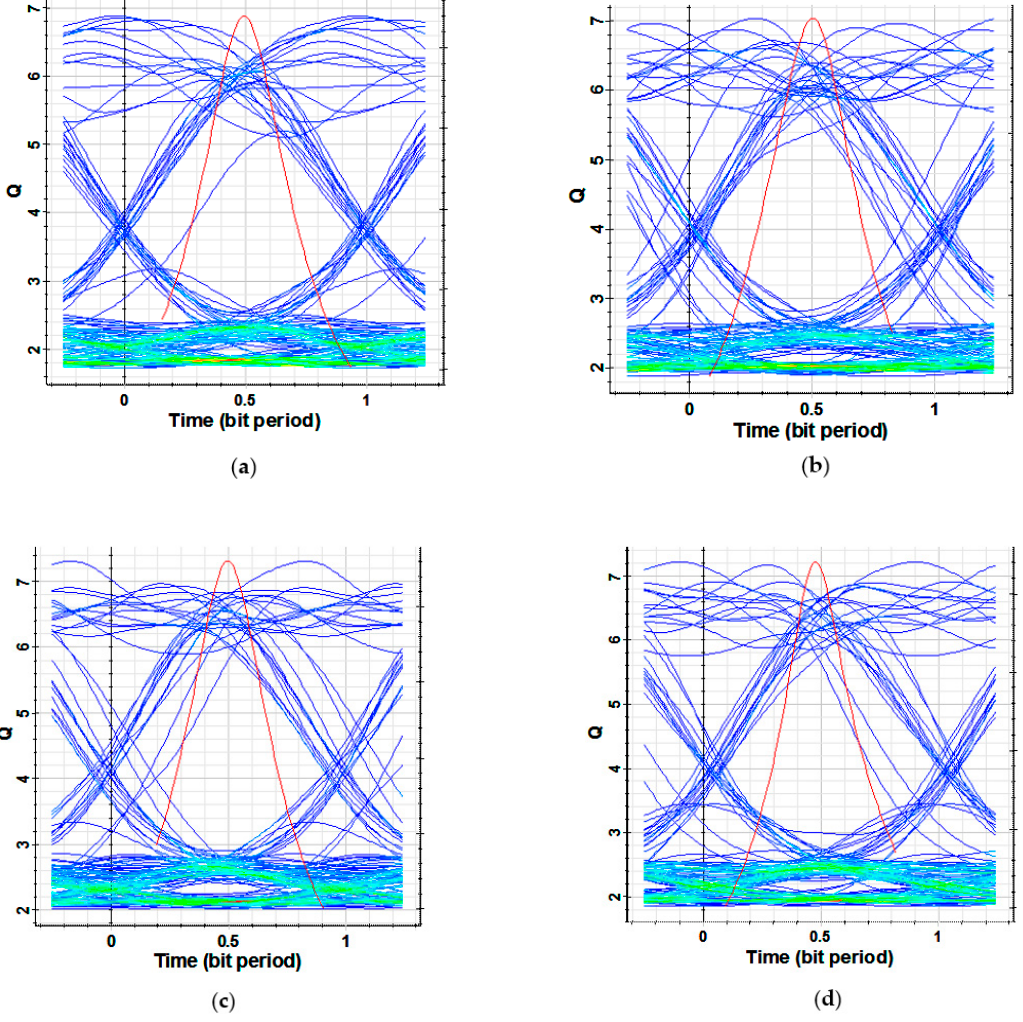
Figure 4. Eye diagrams for odd and even channels after the retransmitting path ( a ) λ 1-1 , ( b ) λ 1-2 , ( c ) λ 8-1, and ( d ) λ 8-2.